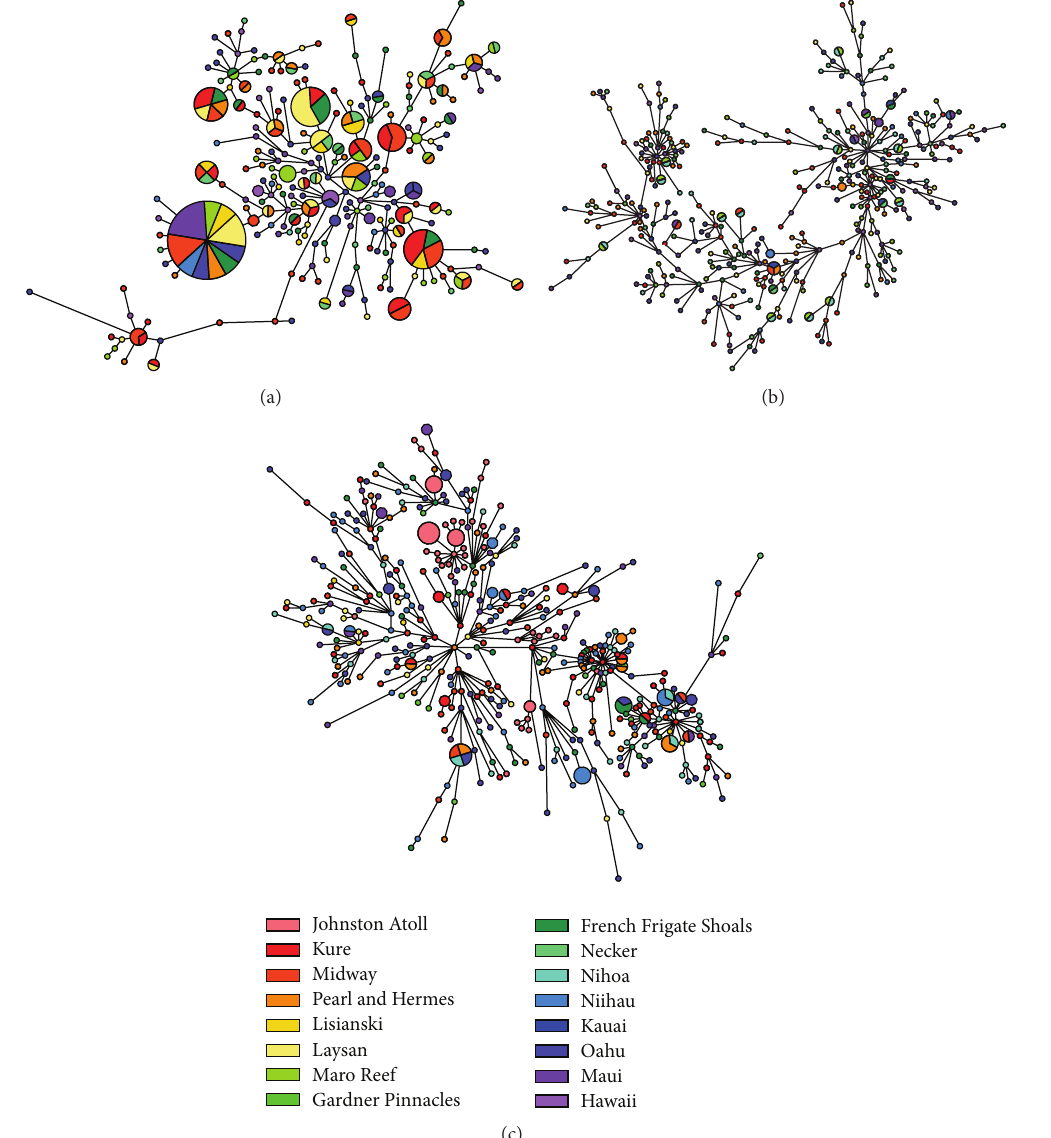
Figure 3: Parsimony-based haplotype networks using CR sequence data for (a) A. abdominalis , (b) C. ovalis , and (c) C. verater . Each circle represents a haplotype and is proportional to the frequency of that haplotype. Length of branches is proportional to number of mutations. Networks are color-coded by sampling location and are not scaled relative to each